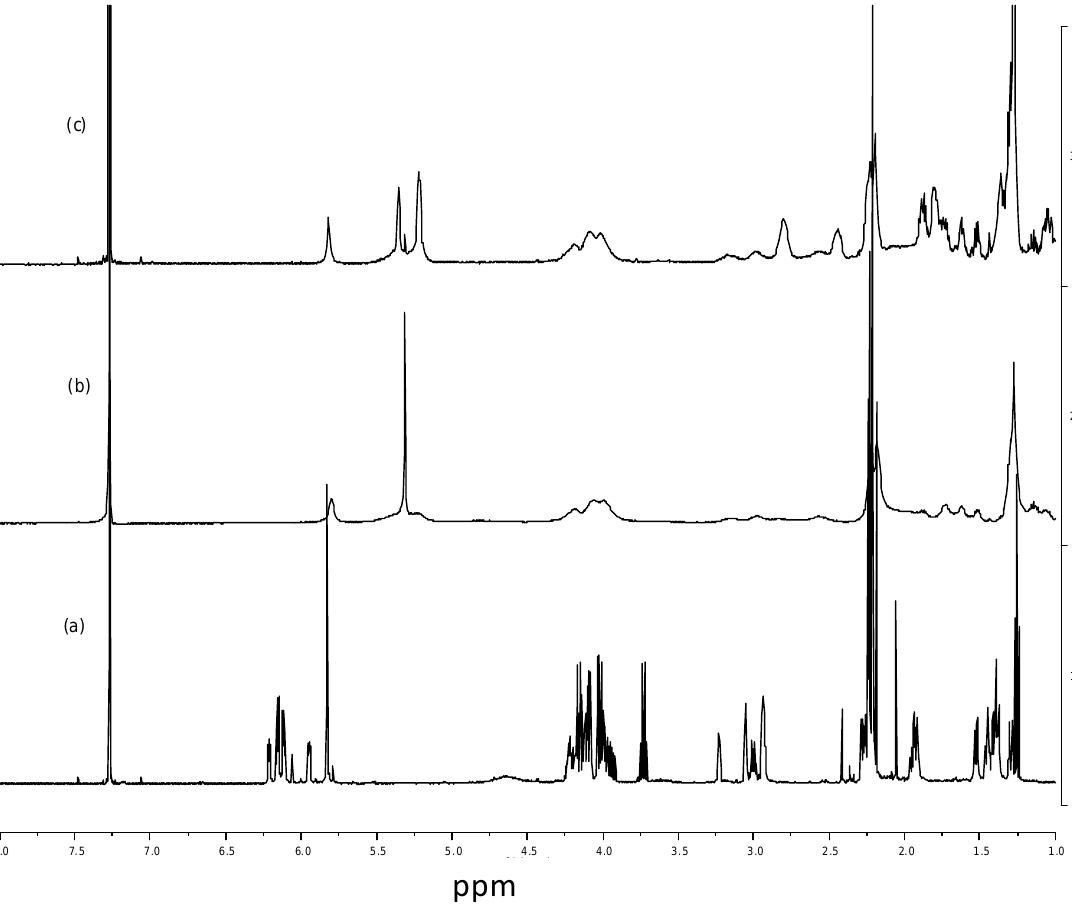
Figure 1. 1 H NMR analysis supporting the formation of 1:1 diblock copolymer; ( a ) monomer 3; ( b ) homopolymer 4; and ( c ) 1:1 diblock copolymer